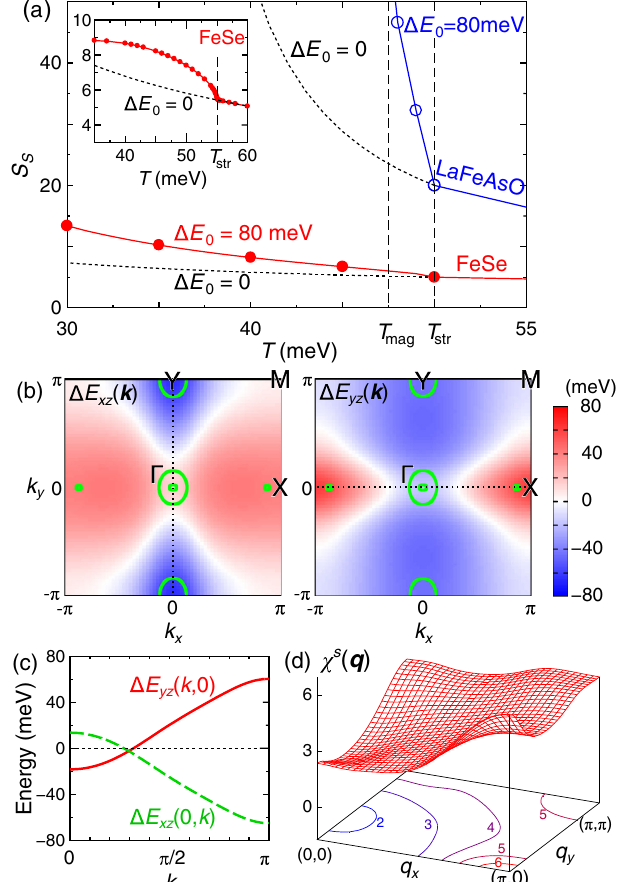
FIG. 4. (a) T dependence of S for both LaFeAsO and S FeSe models ( z ¼ 1 ). The FO order is introduced below 50 meV. Inset: T dependence of S T for the FeSe model S str ¼ obtained by calculating the k -dependent orbital polarization and χ s ð q Þ self-consistently. S tends to saturate below 40 meV S because of the sign-reversing orbital polarization. (b) Self- k Þ , consistent solution of the orbital polarization [ Δ E xz ð Δ E k Þ ] in the orbital ordered state in the FeSe model at yz ð T ¼ 50 meV. The shape of the C 2 -symmetric FSs in (b) is consistent with the experimental reports [27 – 33]. We also show k Þ along the k (c) the Δ E axis and (d) the C 2 -symmetric xz ð yz Þ ð y ð x Þ χ s ð q Þ in the orbital-ordered